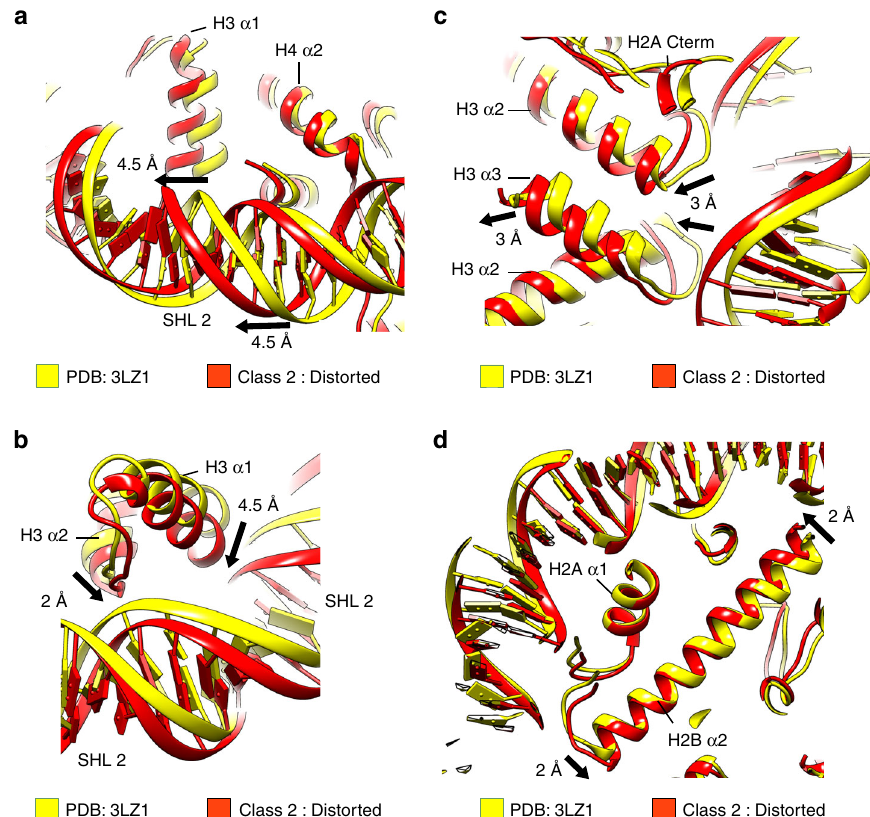
Fig. 2 Structural rearrangements in the histone core. Comparison of the X-ray structure (PDB:3LZ1, yellow) and the Class 2 model (red). Arrows depict the direction of the helix movements. The degree of movement between X-ray structure and the Class 2 model is shown, rounded to half an Å. a Conformational rearrangement of H3 α 1 and DNA at SHL 2. H3 α 1 moves 4.5 Å in Class 2 when compared with the X-ray structure. DNA at SHL 1.5 moves 4.5 Å towards SHL 2. b Conformational rearrangement of the H3 α 2, H3 α 1, and DNA at SHL 2. The H3 α 2 tilts by 2 Å at its N-terminal end. The H3 α 1 moves 4.5 Å. H3 α 1 and H3 α 2 move toward each other and push the DNA at SHL 2.5 outward. c Conformational rearrangement of H3 α 2, H3 α 3, and DNA at the dyad. H3 α 2 tilts and moves inward by 3 Å at its C-terminal end. H3 α 3 also moves inward by 3 Å. Concomitantly, the DNA at the dyad moves more than 3 Å toward the centre of the nucleosome. d Conformational rearrangement of H2B α 2. H2B α 2 tilts by 2 Å toward the center of the nucleosome at SHL 3.5 and 2 Å away from the center at SHL 5.5. This pushes the DNA at SHL 5.5 outward and pulls the DNA at SHL 3.5